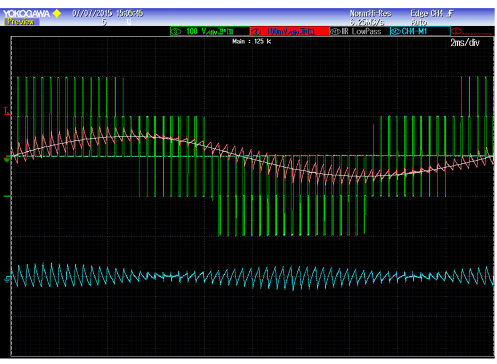
Figure 23. Details of line ‐ to ‐ neutral voltage, instantaneous current, fundamental current, and current ripple for DPWM3, m = 1/6.